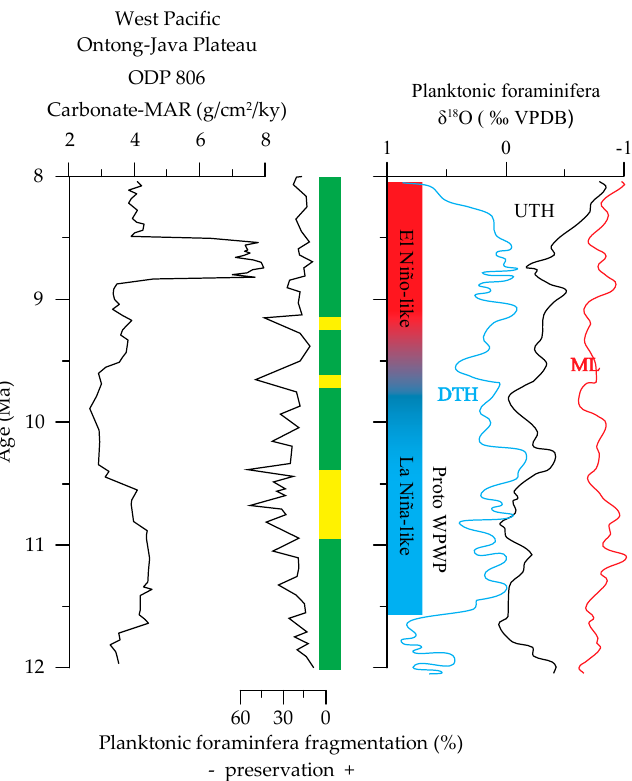
Figure 4. Data after Nathan and Leckie [115] showing the Ontong-Java plateau site 806. The oxygen stable isotope record of deep dwelling foraminifera (DTH), foraminifera record supposed to show the upper thermocline level (UTH) and a mixed layer record (ML). The convergence of DTH and UTH representatives is interpreted as the first occurrence of a stable WPWP. Colour bars refer to the preservation state of planktonic foraminifera as found in the ODP Initial Site Reports. The planktonic foraminifera preservation is preferably good, with lower values at about 10.5 to 9.5 Ma.